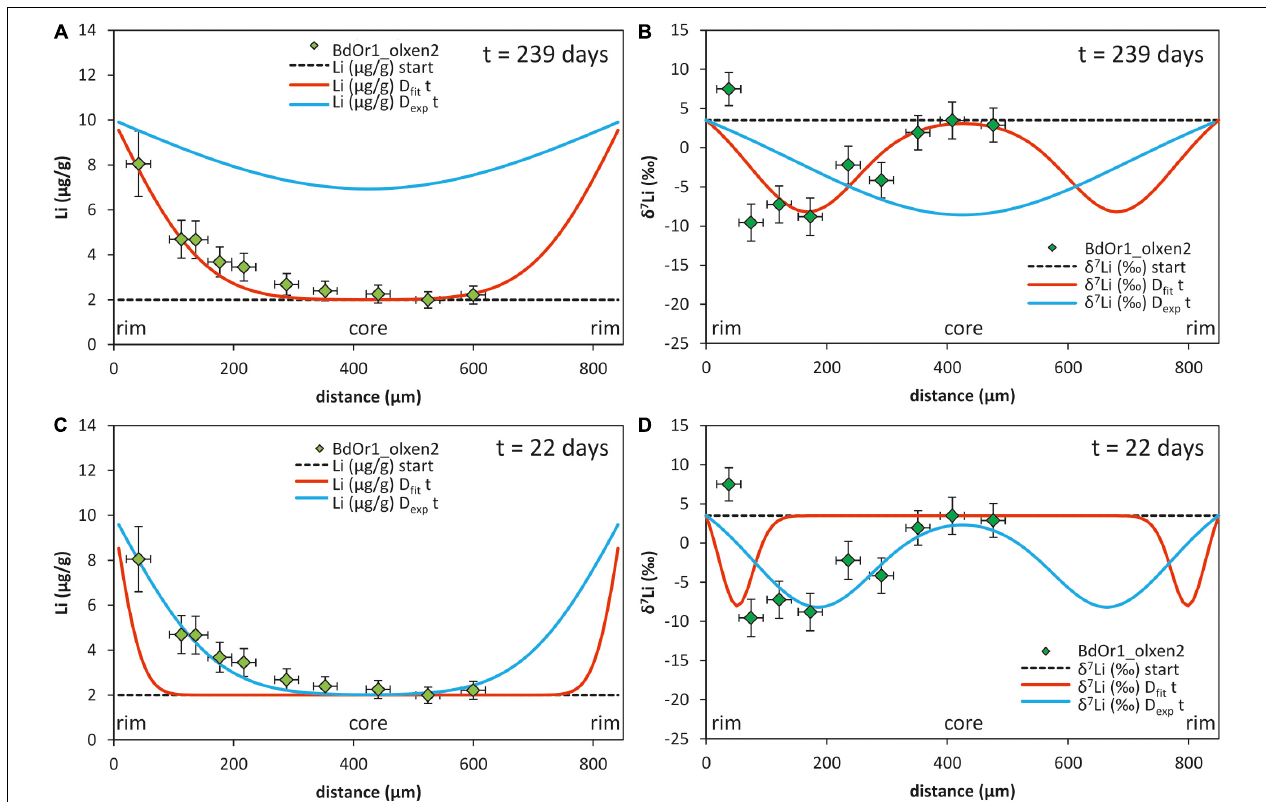
FIGURE 3 | Modeling of the observed Li concentration and isotope composition profiles of olivine grain BdOr1 olxen2 with a 1-step diffusion model; A,B ) by using the times scale as determined by Fe–Mg modeling ( t = 239 days, taken from Oeser et al., 2015) and fitting the Li diffusivity ( D fit ) to the measured profiles (red line); for comparison the same model (with t = 239 days) is shown using D exp of Dohmen et al. (2010) which does not match the observed Li concentration and isotope profiles (blue lines). (C,D) the same model is shown using the diffusivity D exp (Dohmen et al., 2010) and fitting the time scale to match the Li concentration and isotope profiles yields a diffusion time of t = 22 days (blue line); for comparison the profile is also modeled with the same time applying the fitted diffusivity from (A,B) (red line). All fits were modeled assuming a diffusivity D exp = 4.42*10 - 15 m 2 /s according to a temperature of 1250 ◦ C and D fit = 3.5*10 - 16 m 2 /s.